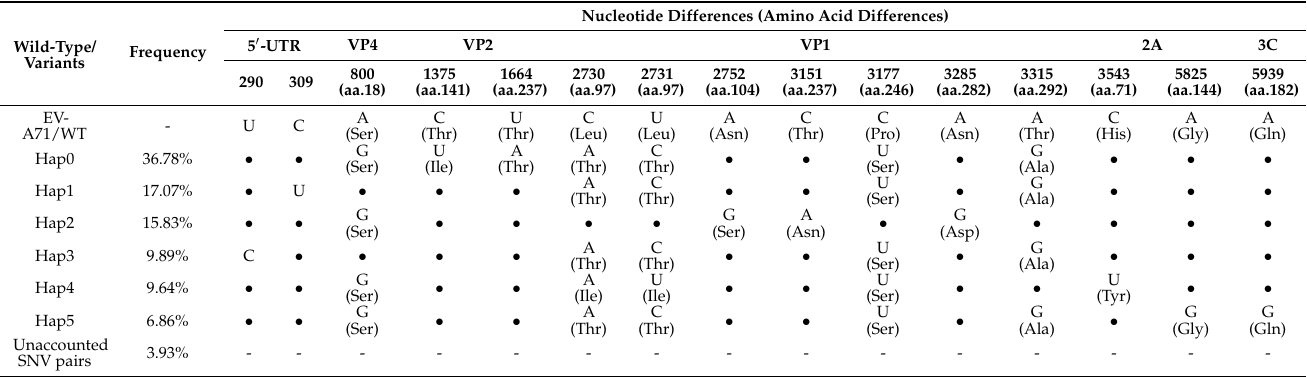
Table 2. Abundance and nucleotide and amino acid differences found in the six haplotypes. Nucleotide Differences (Amino Acid